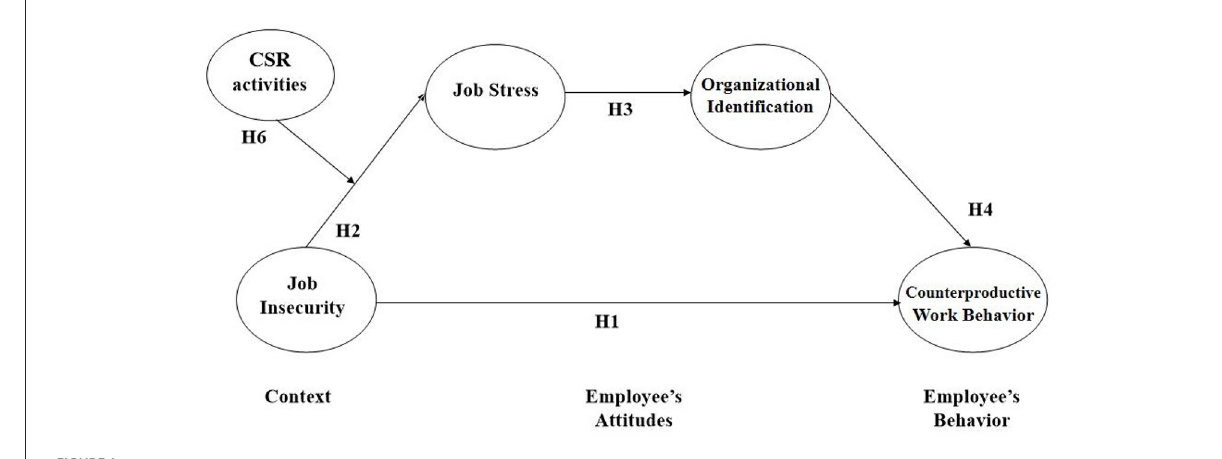
FIGURE1 Theoretical